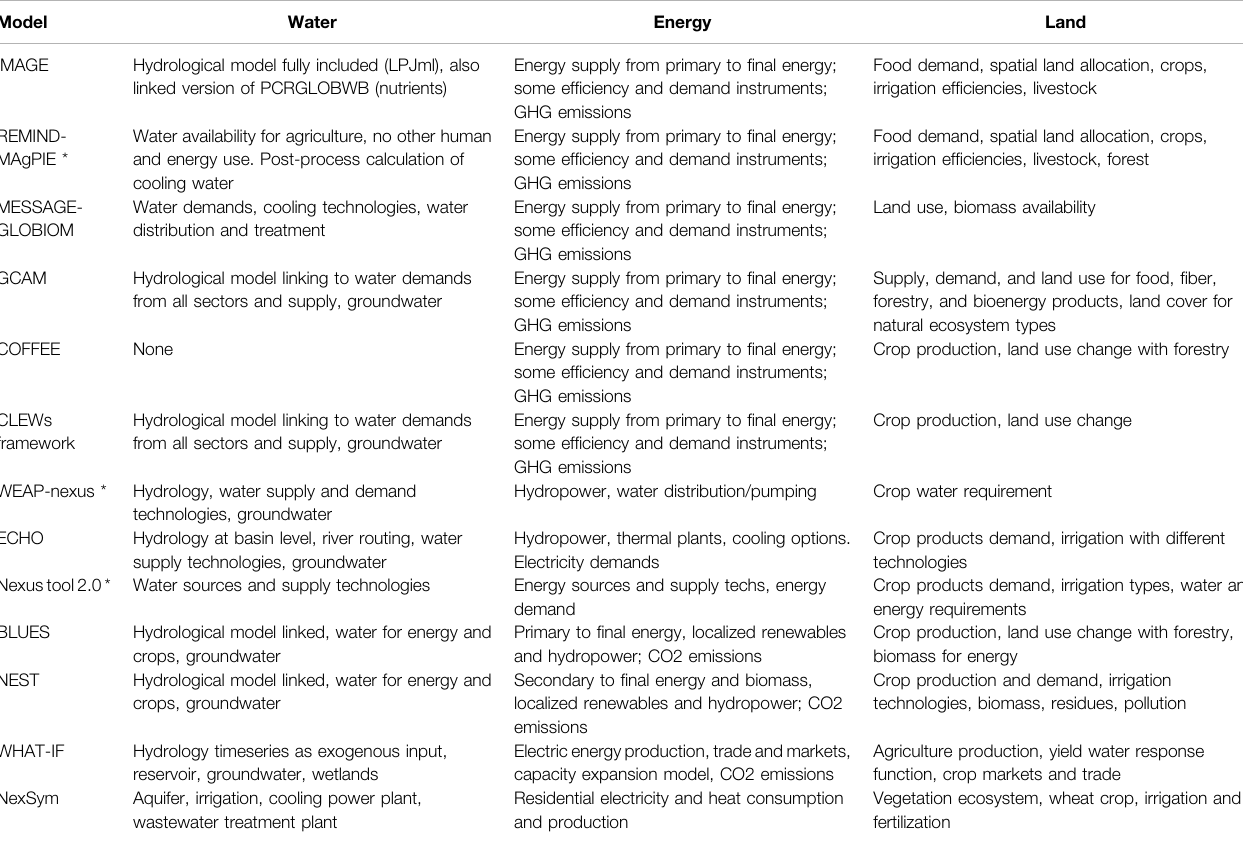
TABLE 2 | Comparison of CLEW models sectoral